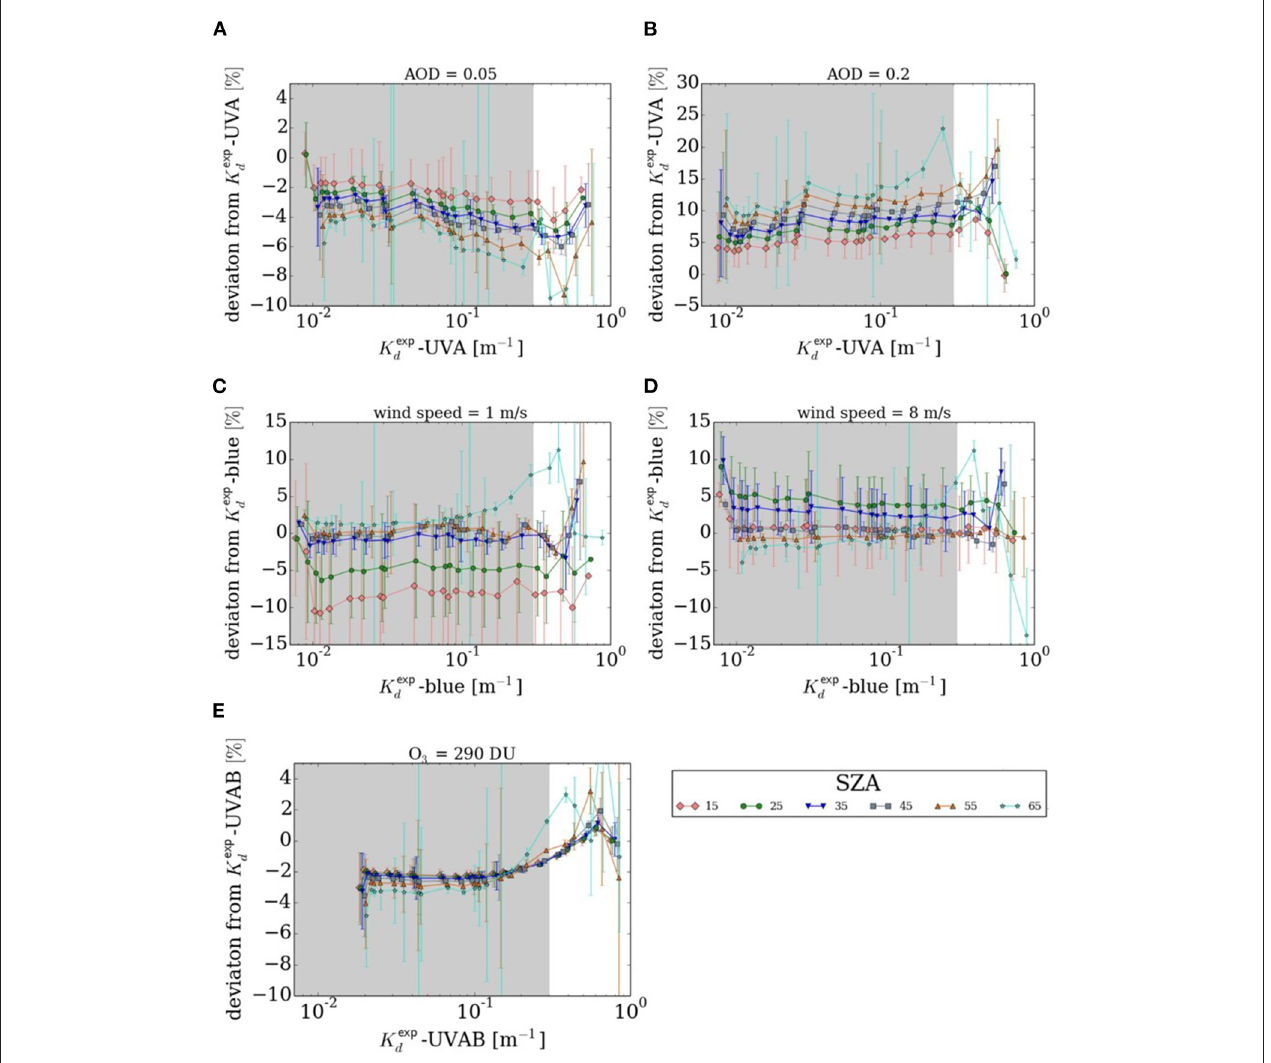
FIGURE 8 | Deviation of derived from expected K d in case of (A) reduced AOD, (B) increased AOD, (C) reduced wind speed, (D) increased wind speed, and (E) reduced ozone column for different SZA. Results were averaged for different VZA with the standard deviation given as errorbar. Panels (A,B) show results for K d -UVA, (C,D) for K d -blue, and (E) for K d -UVAB.